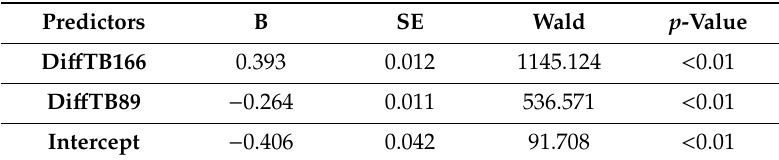
Table 2. Logistic regression model coe ffi cients and statistics for the vertical and horizontal polarization brightness temperature di ff erence at GMI 166 GHz (Di ff TB166) and 89 GHz (Di ff TB89) as predictors. “B” indicates the partial regression coe ffi cient, “SE” indicates the standard error and “Wald” indicates the observed Wald test statistic.